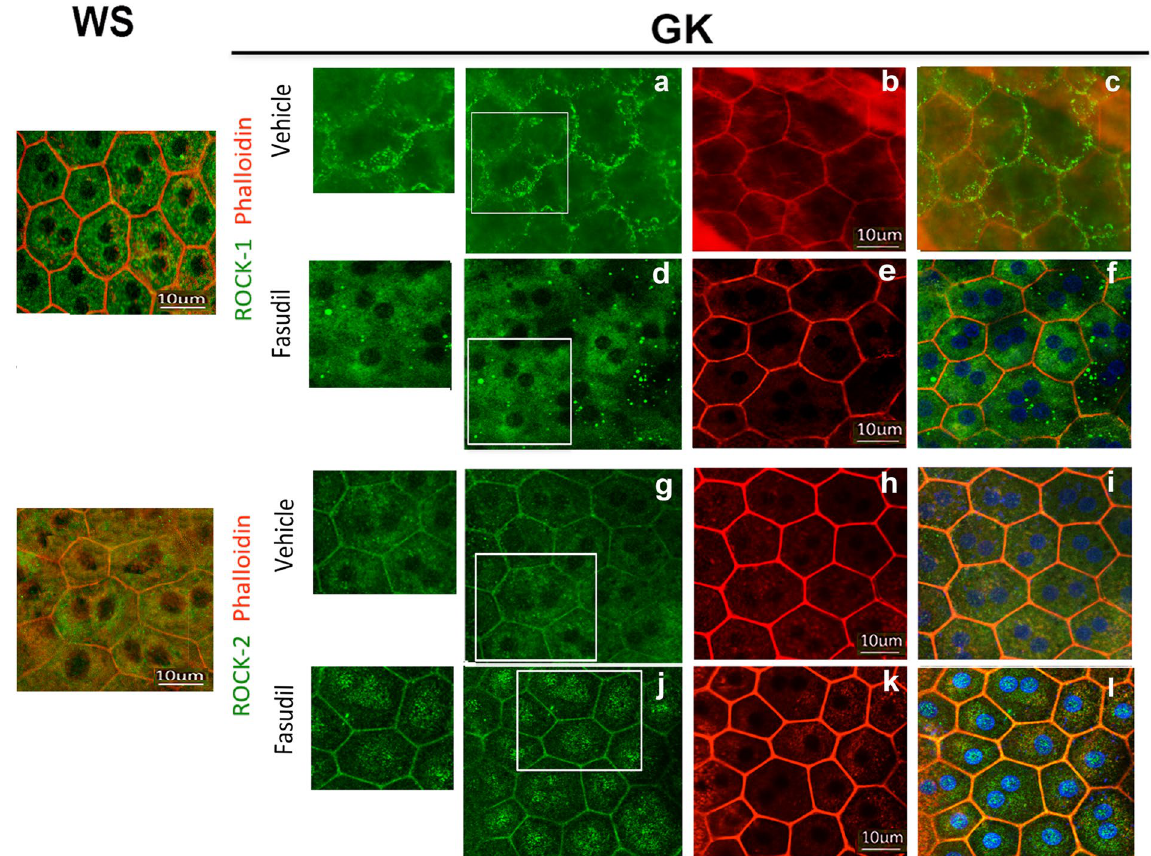
Figure 5. Effect of fasudil on ROCK-1 and ROCK-2 cellular distribution in diabetic RPE cells. Double staining ROCK-1 or ROCK-2 with Phalloidin on RPE cell flatmounts showed that Fasudil relocates ROCK-1 (a,b) from the membrane the cytoplasm in the Fasudil treated GK rat consistent with their inactivation and that it did not change the membrane distribution of ROCK-2 but induced an increased nuclear and perinuclear localization of ROCK-2 (g,j). (n = 5 per experiment). Scale bar = 10 µ